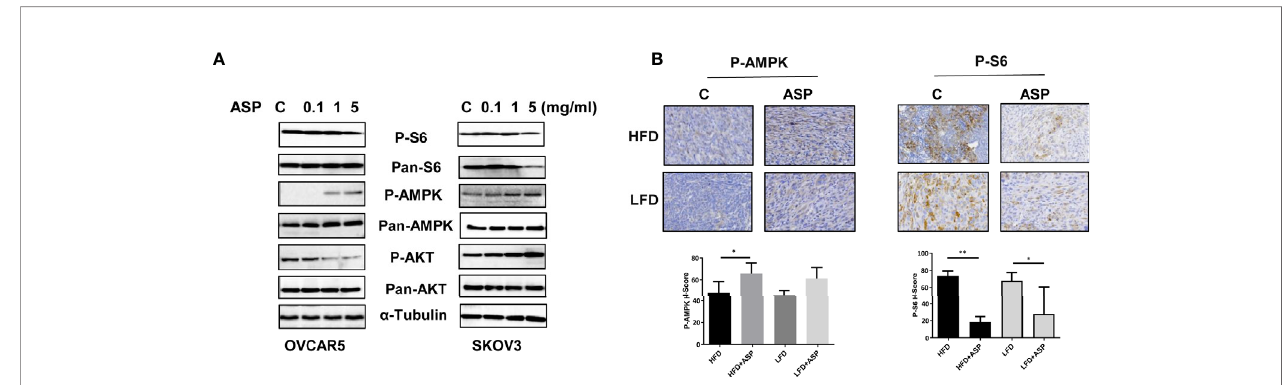
FIGURE 7 | ASP activated AMPK and inhibited the AKT/mTOR pathways. The OVCAR5 and SKOV3 ovarian cell lines were treated with ASP at indicated doses for 24 hours. The expression of phosphorylated AMPK, Akt and S6 was analyzed by western blotting. ASP increased the expression of phosphorylated AMPK and decreased the expression of phosphorylated S6 in both cell lines. ASP decreased the expression of phosphorylated AKT in the OVCAR5 cells and increased phosphorylated AKT expression in the SKOV3 cells (A) . IHC results showed that ASP increased phosphorylated AMPK and decreased phosphorylated S6 expression in the ovarian cancer tissues of obese and lean mice (B) . *p < 0.05; **p < 0.01.